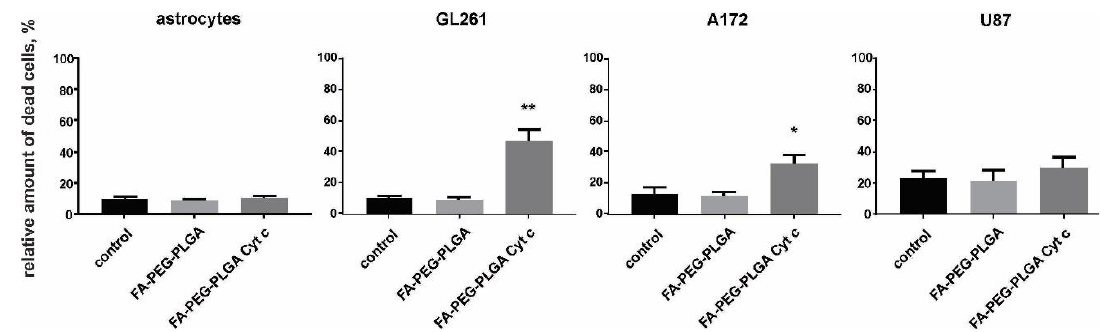
Figure 2. The viability of glioma cells and mouse primary cultured astrocytes treated with FA-coated Cyt c NPs (100 μg/mL). A live/dead assay based on calcein and ethidium homodimer-1 staining of live and dead cells was performed after 24 h of treatment with FA-Cyt c NPs. Quantitation of the number of dead cells as a percentage of the total number of cells is presented for the following treatments: control (untreated), FA-conjugated NPs not containing Cyt c (FA-PEG-PLGA), and FA-conjugated